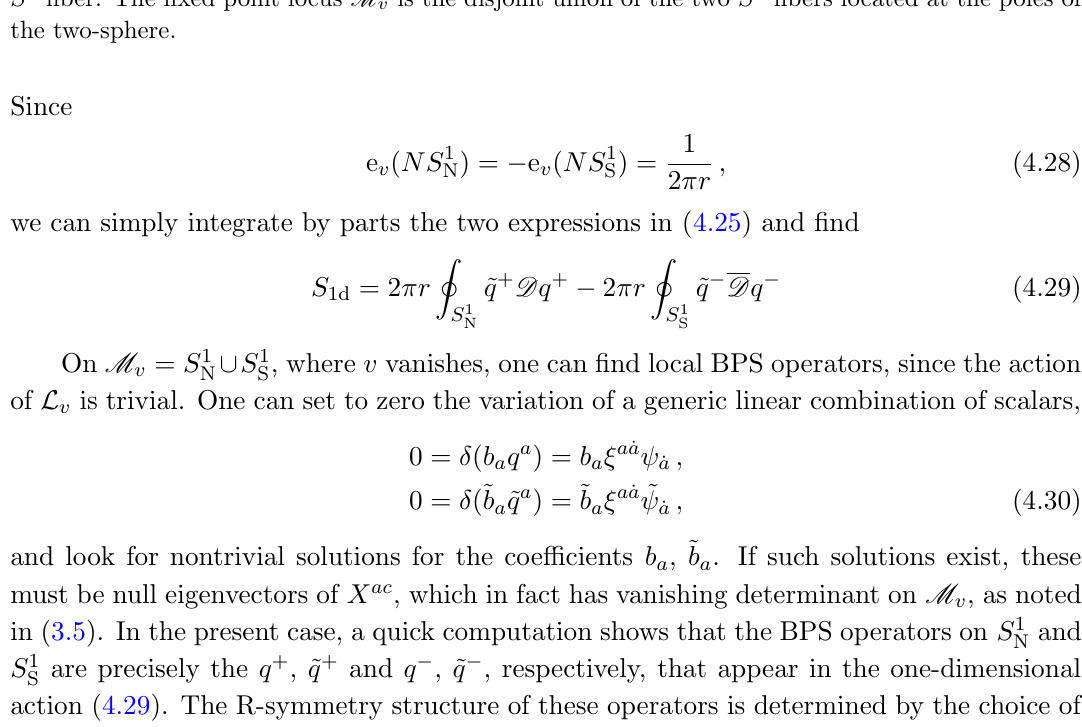
Figure 2 . A graphical representation of the quotient M v = ( S 2 (cid:2) S 1 ) = U(1), where the U(1) acts as the azimuthal rotation generated by @ ’ . In the picture, every point on the sphere has an asssociated S 1 (cid:12)ber. The (cid:12)xed point locus M v is the disjoint union of the two S 1 (cid:12)bers located at the poles of the